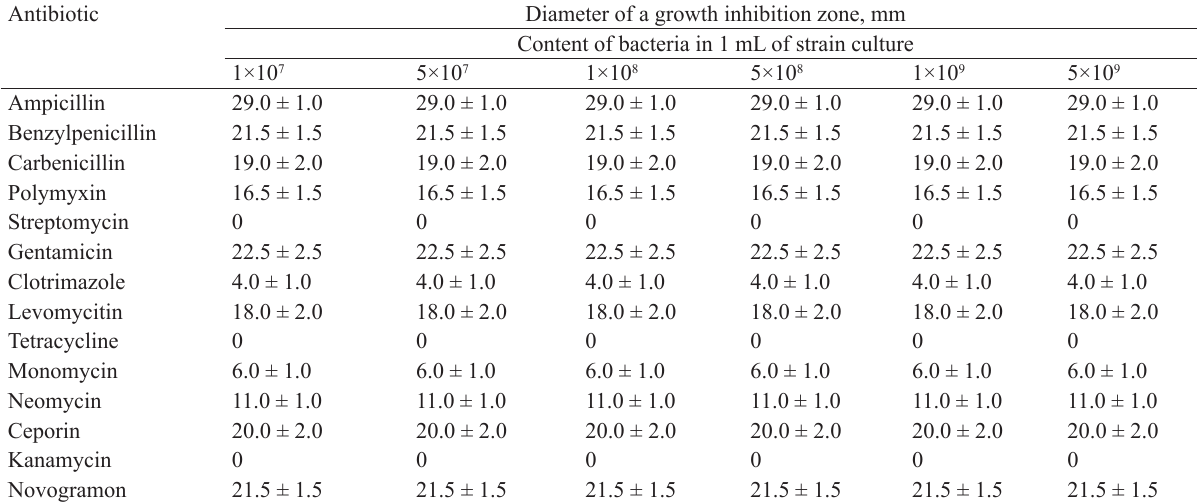
Table 3 Antibiotic resistance of Leuconostoc lactis isolate Antibiotic Diameter of a growth inhibition zone, mm Content of bacteria in 1 mL of strain culture